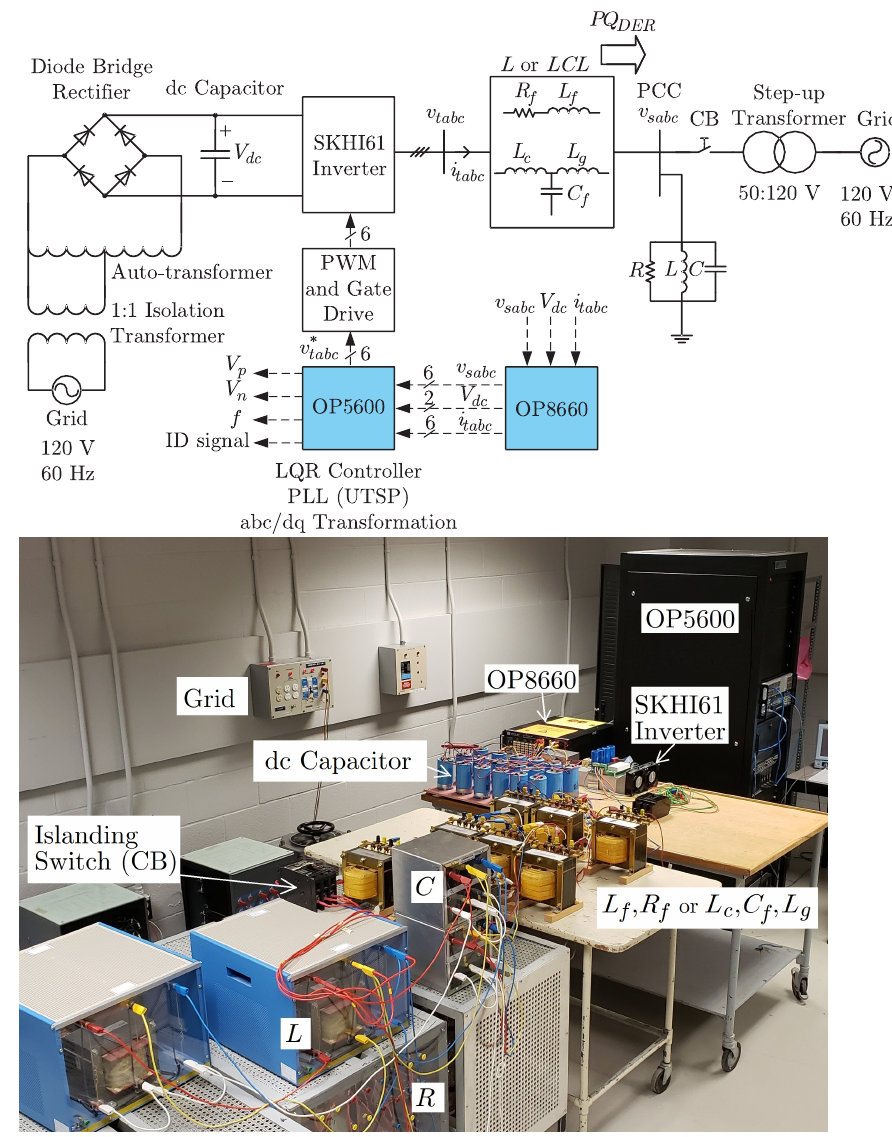
Figure 7. Experimental setup: ( top ) a block diagram of the circuit, and ( bottom ) the laboratory